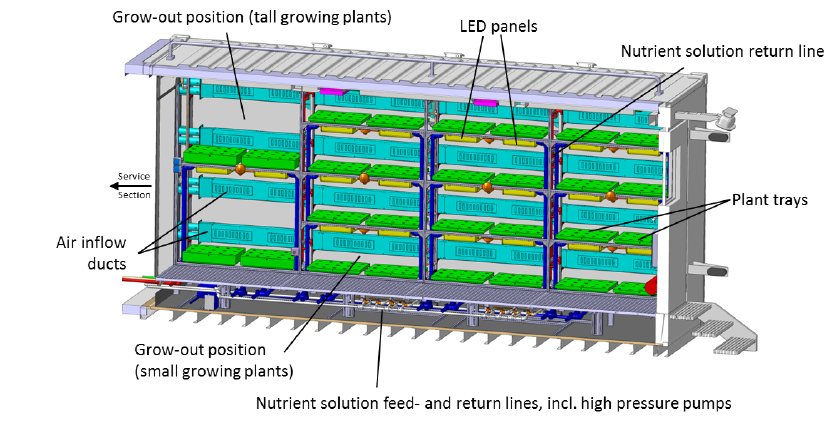
Figure 1: Tray layout of one wall within the EDEN ISS Future Exploration Greenhouse (FEG). The FEG is part of the Mobile Test Facility (MTF), which will be deployed to Neumayer Station III in 2018 as part of an analogue mission for testing closed-loop plant cultivation technologies. Service Section is not shown in the figure.